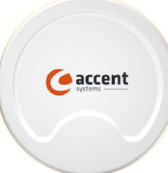
Figure 1. iBKS 105 beacon (Source: https://accent-systems.com/product/ibks-105/, (accessed on 12 June 2021).